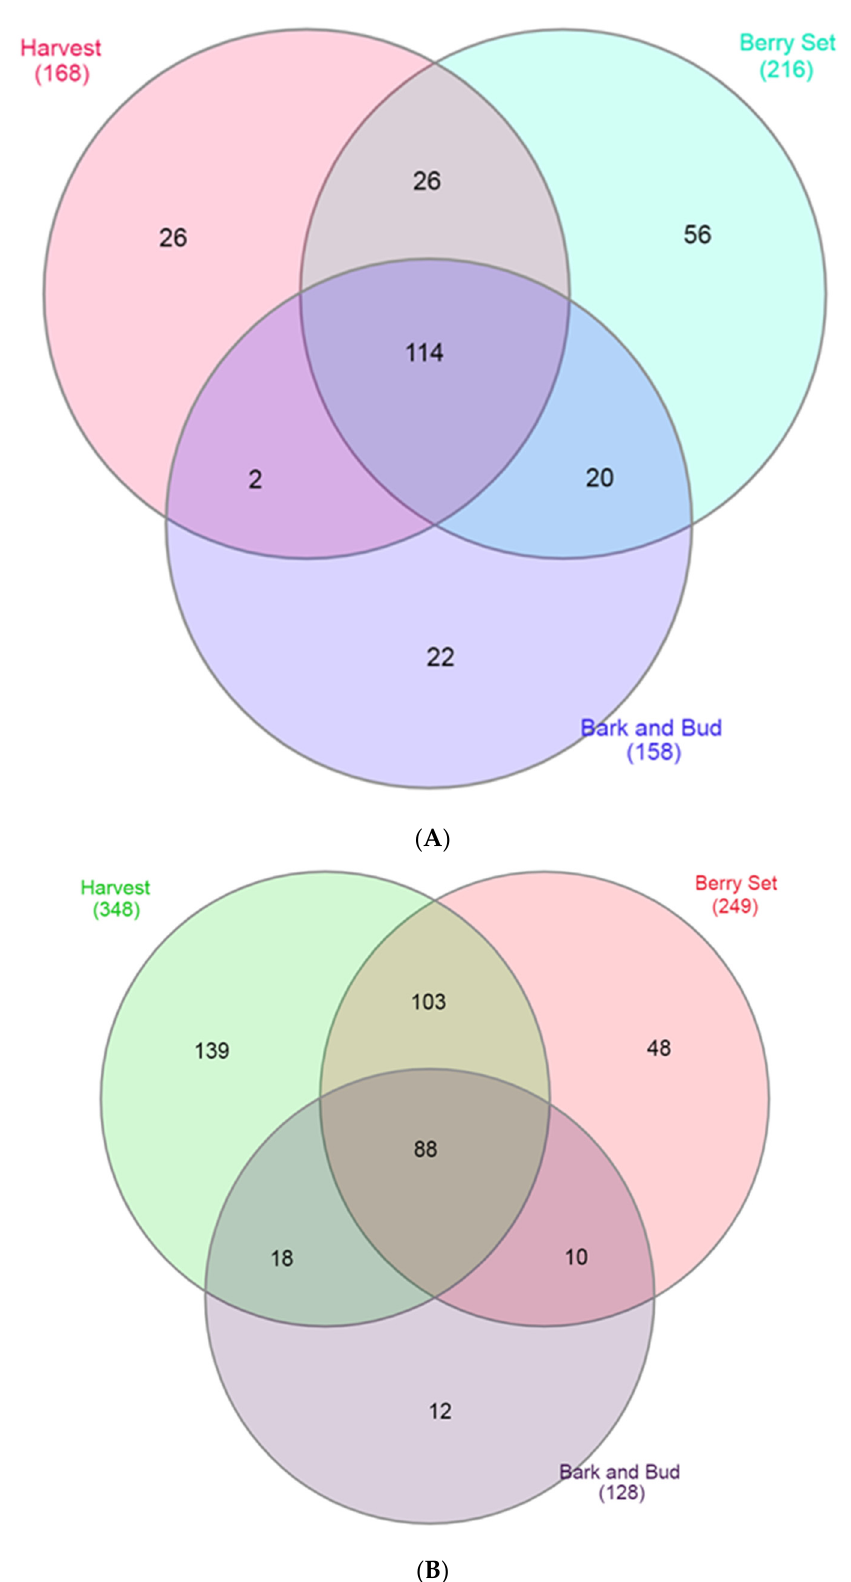
Figure 4. Venn diagrams that show the fungal (A) and bacterial (B) genera distribution among the three phenological stages.